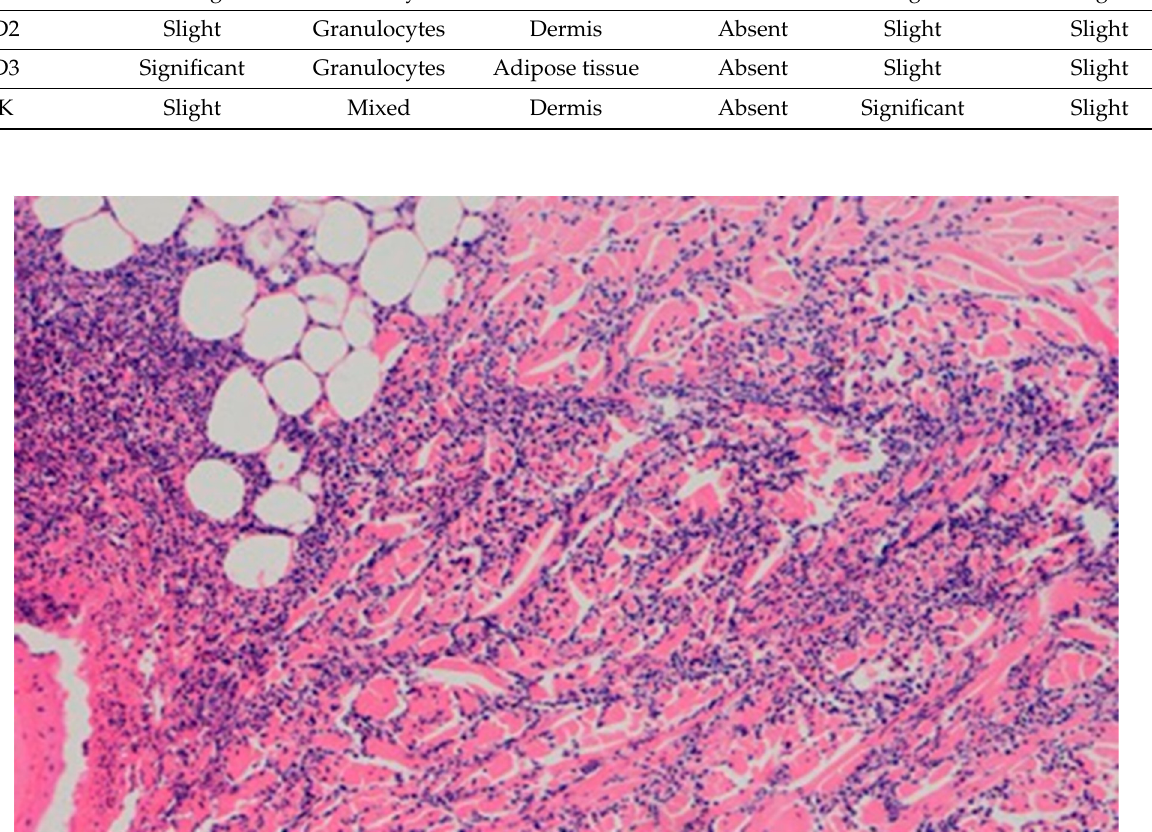
Figure 13. Granulocytic inflammatory infiltration on the border of the dermis and subcutaneous tissue (100×, H-E), in the wound treated with the ointment with 1% propolis and 1% nanosilver, on day 5.